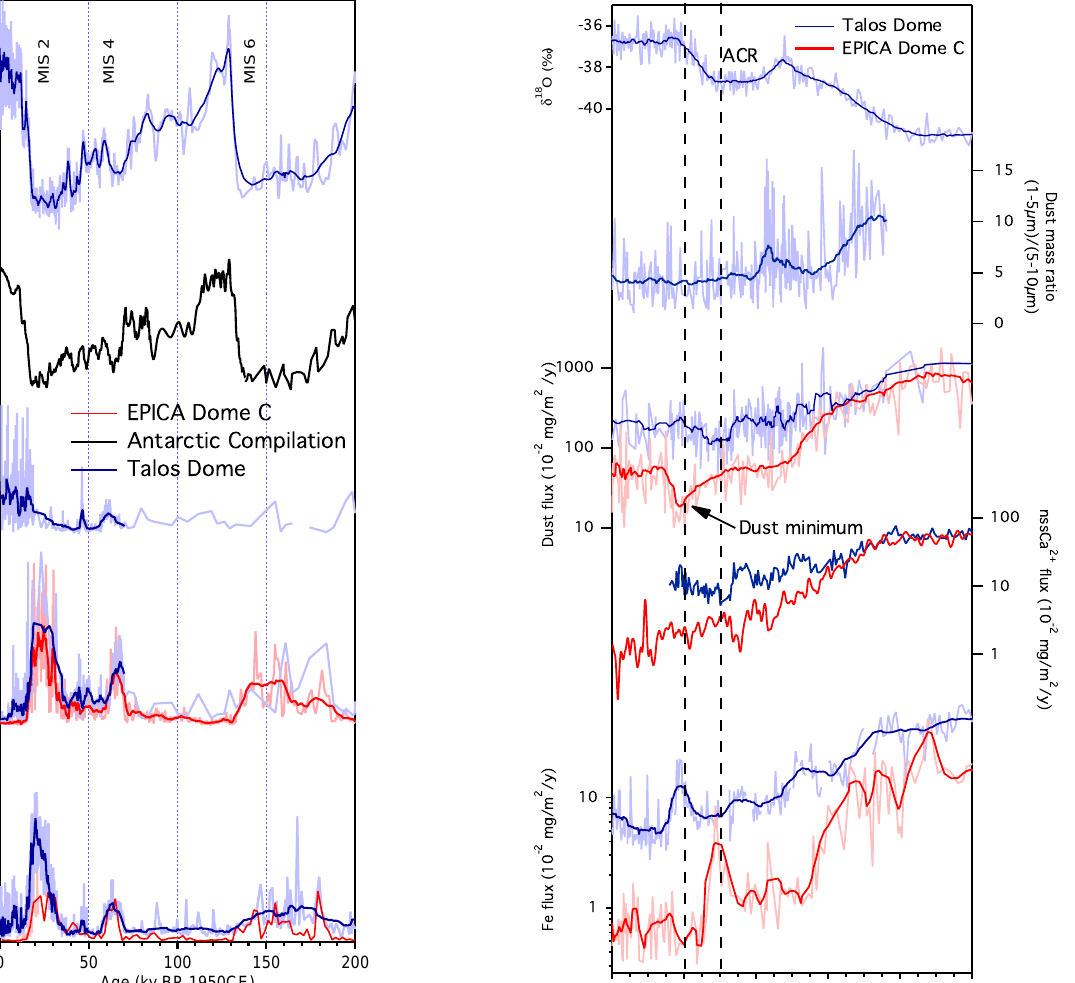
( < 5 × 10 − 2 mg m − 2 a − 1 ) values throughout the Holocene, with highest values during the mid-Holocene (7–10 kyr